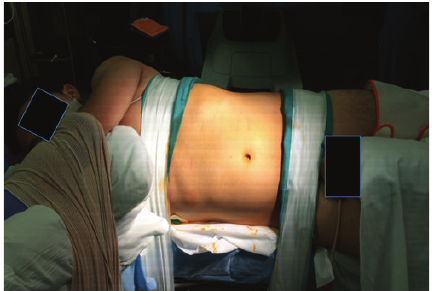
Figure 2: Patient positioning for left robotic partial